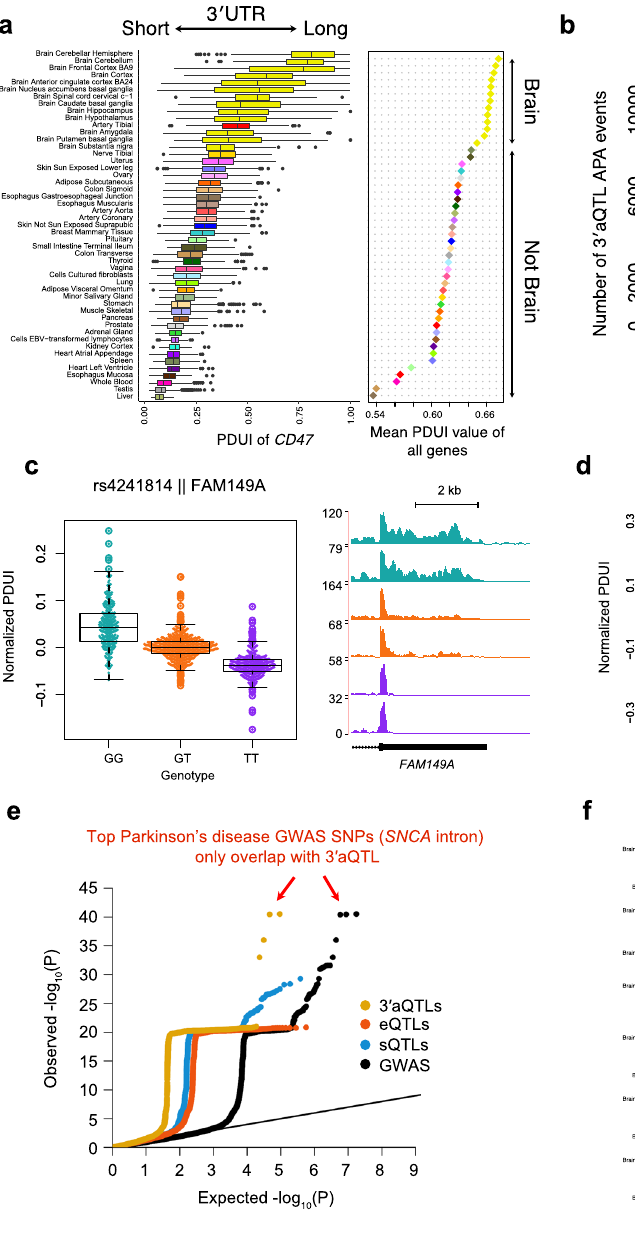
values and the boxes are bounded by the 25th and 75th percentile. The whiskers extend to the maximum and minimum values within 1.5 times of the interquartile range. Right panel: RNA-seq coverage tracks for the FAM149A 3 ′ UTR. The bottom track shows the RefSeq gene structure. d Similar to ( c ) but for MAPT in the Psy- chENCODE cohort ( n =1520 biologically independent samples). The center hor- izontallineswithintheplotrepresentthemedianvaluesandtheboxesarebounded by the 25th and 75th percentile. The whiskers extend to the maximum and mini- mum values within 1.5 times of the interquartile range. e Example of Parkinson ’ s disease quantile – quantile plot (QQ plot) showing the nominal P -values of brain disorder GWAS SNPs, which were binarily annotated by 3 ′ aQTLs (yellow), sQTLs (blue), and eQTLs (light orange) with nominal P -value<10 − 5 . Each dot represents a GWAS SNP. All Parkinson ’ s disease GWAS nominal P -values are also shown as controls (black). f Enrichment of 3 ′ aQTLs in seven brain disorder GWAS SNPs (nominal P -value<10 − 5 ) acrossGTExbrain tissues. 3 ′ aQTLsare calculated based on 2181RNA-seqsamplesofbraintissuesfromtheGTExcohort.Dataarepresentedas mean values±SEM. OR odds ratio.